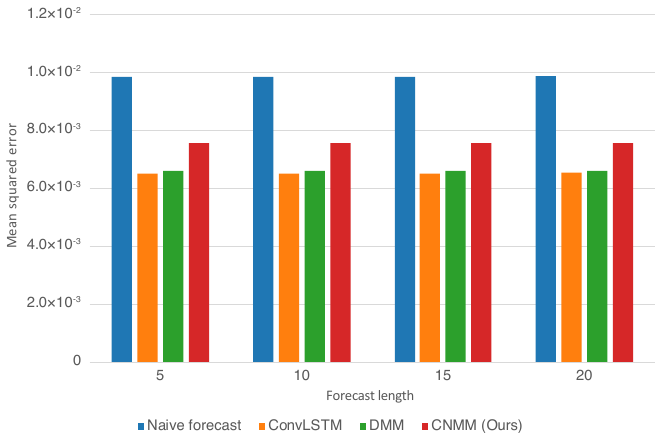
Figure 5. Forecast MSE on the CMAP data when plotted as bar graphs. The y-axis represents the MSE. The x-axis represents the forecast length and the model with which the forecast is